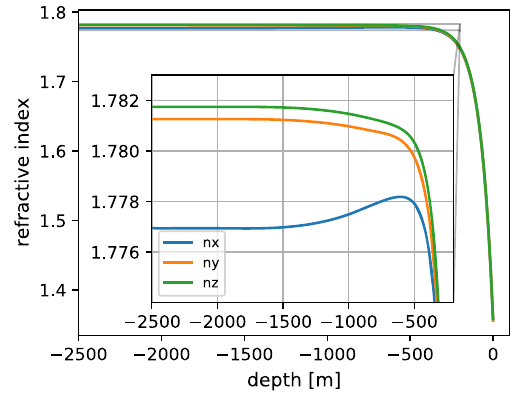
Fig. 2 Refractive index as a function of depth. Combination of bire- fringence and density effects. The zoomed-in version highlights the birefringence effects seen in Fig. 1 while the zoomed out version high- lights the density effects from Eq.